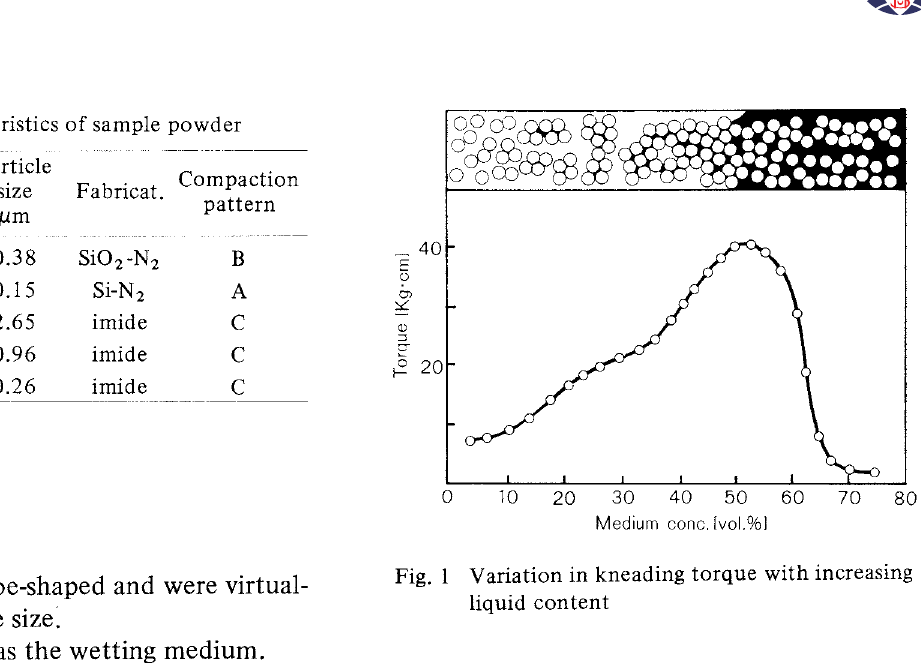
Fig. 1 Variation in kneading torque with increasing liquid